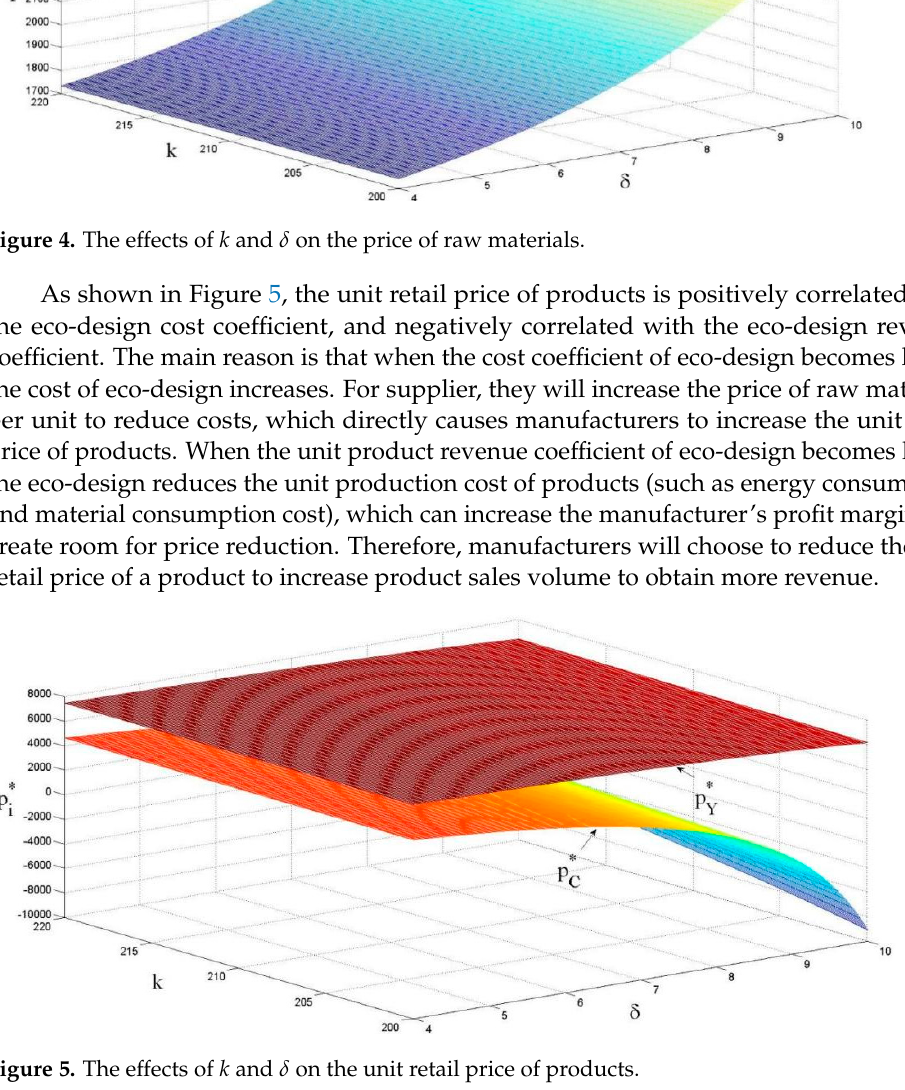
Figure 5. The effects of k and